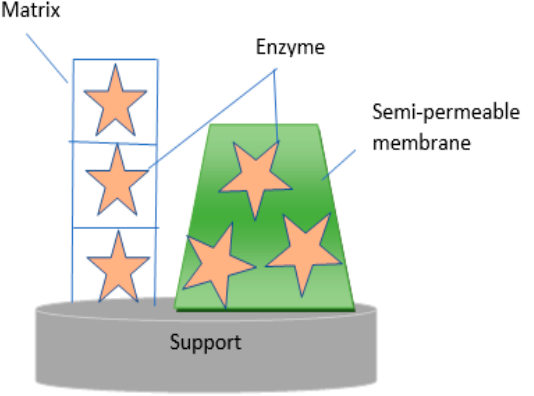
Figure 7. Enzyme immobilisation by entrapment/encapsulation method.